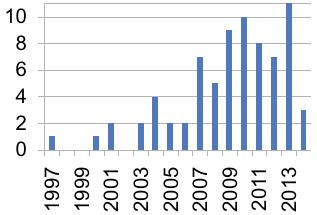
Figure 2: Number of related papers by publication year Some related papers are highlighted in Ref. 10